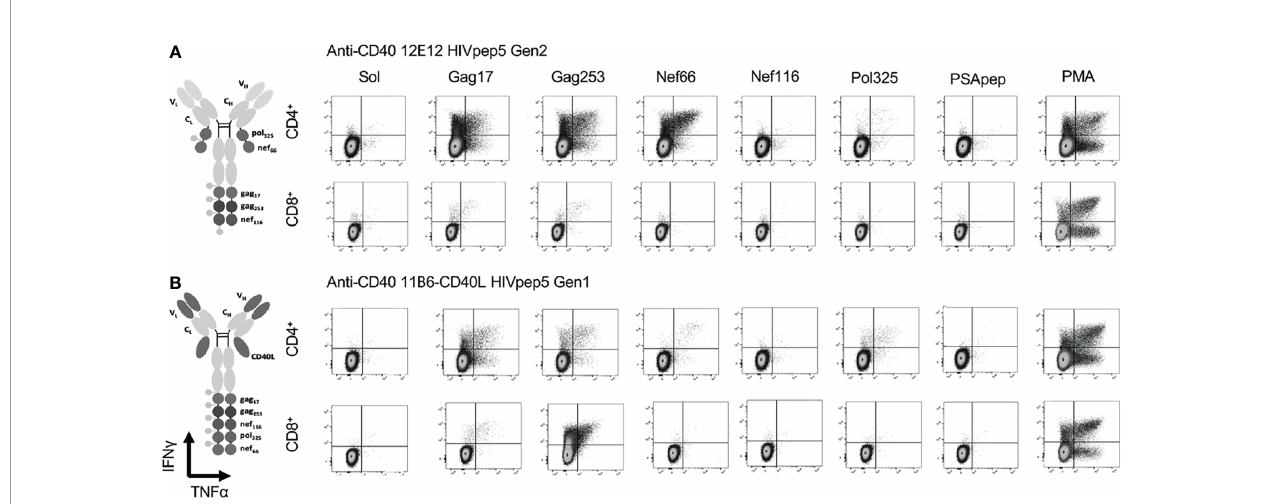
FIGURE 5 | CD40-targeted HIV5pep antigens with and without fused CD40L tested via in vitro expansion of HIV-1-speci fi c T cells in HIV-1-infected donor PBMC cultures. HIV-1 + donor 1 PBMCs were cultured for 9 days with IL-2 and anti-CD40 HIV5pep fusion proteins (1 nM), followed by stimulation with long peptides speci fi c for each of the fi ve HIV-1 Gag, Nef, and Pol regions for 6 h with Golgi Stop + BFA, then analyzed by ICS. This is IHC data from one experiment with two of the four indicated proteins tested on one of the donors shown in Figure 6 . PSApep and sol indicate, respectively, non-relevant peptide and solvent only negative controls, and PMA represents polyclonal stimulation by Phorbol 12-Myristate 13-Acetate and Ionomycin. Minimal responses to speci fi c peptides were observed in cultures expanded without vaccine stimulation (not shown) or with hIgG4-HIV5pep non-targeting control protein (7). (A) shows responses elicited by anti-CD40 12E12 HIV5pep Gen 2, and (B) shows responses elicited by anti-CD40 11B6-CD40L-HIV5pep Gen 1. Previous data show that Gen 1 versus Gen 2 HIV5pep con fi guration on anti-CD40 12E12 elicit identical ranges and extent of responses in similar experiments (14). Supplemental Figure 3 shows similar data for